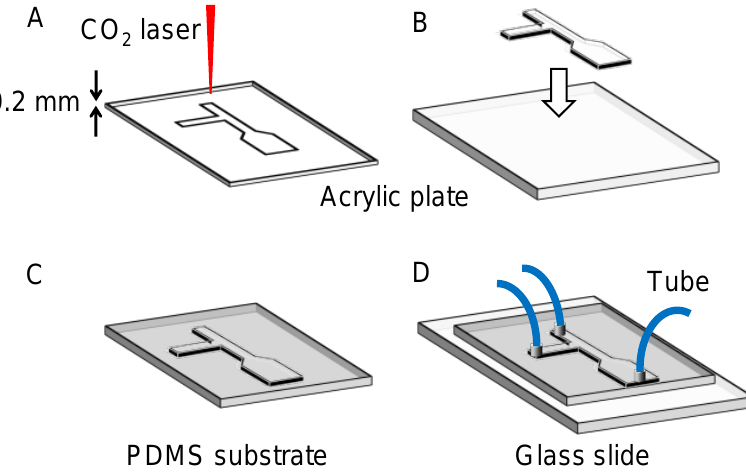
Figure 2. Schematic illustrations of fabrication procedures of the microfluidic device. ( A ) Cutting acrylic plate with CO 2 laser. ( B ) Bonding. ( C ) Molding. ( D ) Bonding and tubing. PBS (T900, Takara bio, Shiga, Japan) or an aqueous solution of PEG (average MW: 7000–9000, 10%) were used as the dispersed phase. The dispersed phase was infused into the channel at 1 µ L min − 1 by a syringe pump (Legato 111, KD Scientific, Holliston, MA, USA). An oil for droplet digital PCR (1864005, Bio-Rad, Hercules, CA, USA) was used as the continuous phase. The continuous phase was infused into the channel at 4~40 µ L min − 1 by another syringe pump. Bright field images were acquired using an inverted microscope (IX71, Olympus) equipped with a CMOS camera (ORCA-Flash 4.0 V2, Hamamatsu Photonics) and a 4 × objective lens. HSR Software (Hamamatsu Photonics) and Image J (National Institutes of Health) were used to process the